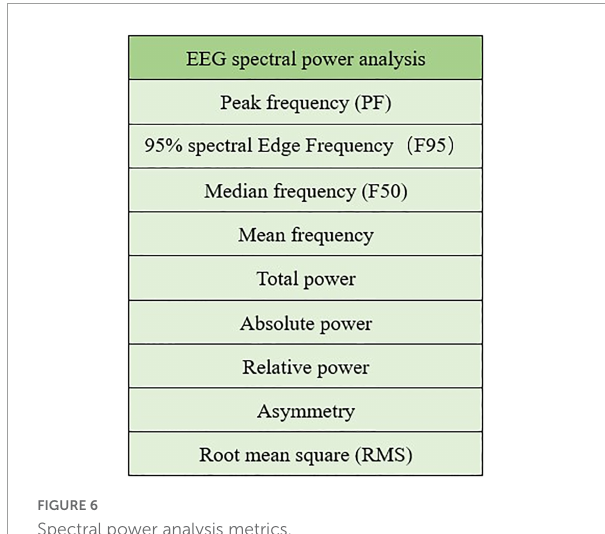
FIGURE6 Spectral power analysis metrics.